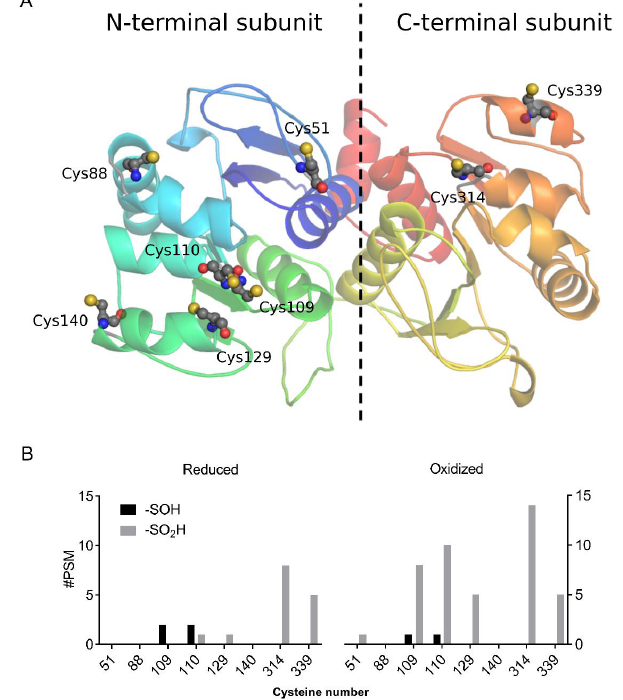
Figure 1 . AtDJ-1B cysteines are differentially oxidized upon H 2 O 2 treatment. ( A ) Homology model of AtDJ-1B with annotated cysteines in ball-and-stick representation. A dotted line approximately marks the 2-fold pseudosymmetry axis arising from the pseudo-dimeric AtDJ-1B monomer. Model generated using the I-TASSER structural prediction server, wherein the crystal structure of AtDJ-1D (PDB ID, 3UK7) was applied as a threading template. ( B ) Number of peptides (#PSM) detected by mass spectrometry that contained sulfenylated (-SOH) and sulfinylated (-SO 2 H) cysteines, either in a sample reduced by 5 mM TCEP or oxidized by 10-fold molar excess of H 2 O 2 for 1